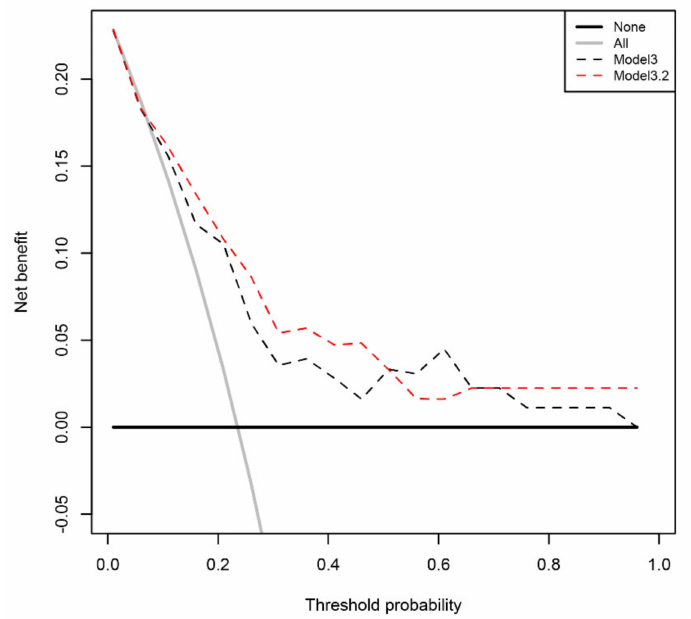
Figure 1. Decision curve analysis. The net benefit of using the mathematical models for biopsy indication instead of the extreme strategies is shown. Model3 includes PSA level, patient age and previous biopsy status, model3.2 includes PSA level, patient age, previous biopsy status, and the expression levels of miR-486 and let-7c. Model3.2 provides a benefit over the extreme strategies of recommending a biopsy in all patients or recommending a biopsy for no patient within a threshold range of 7% to 97%.